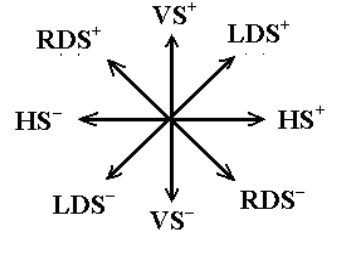
Fig. 1. The star chart illustrating 4 kinds of sliding of a spatial